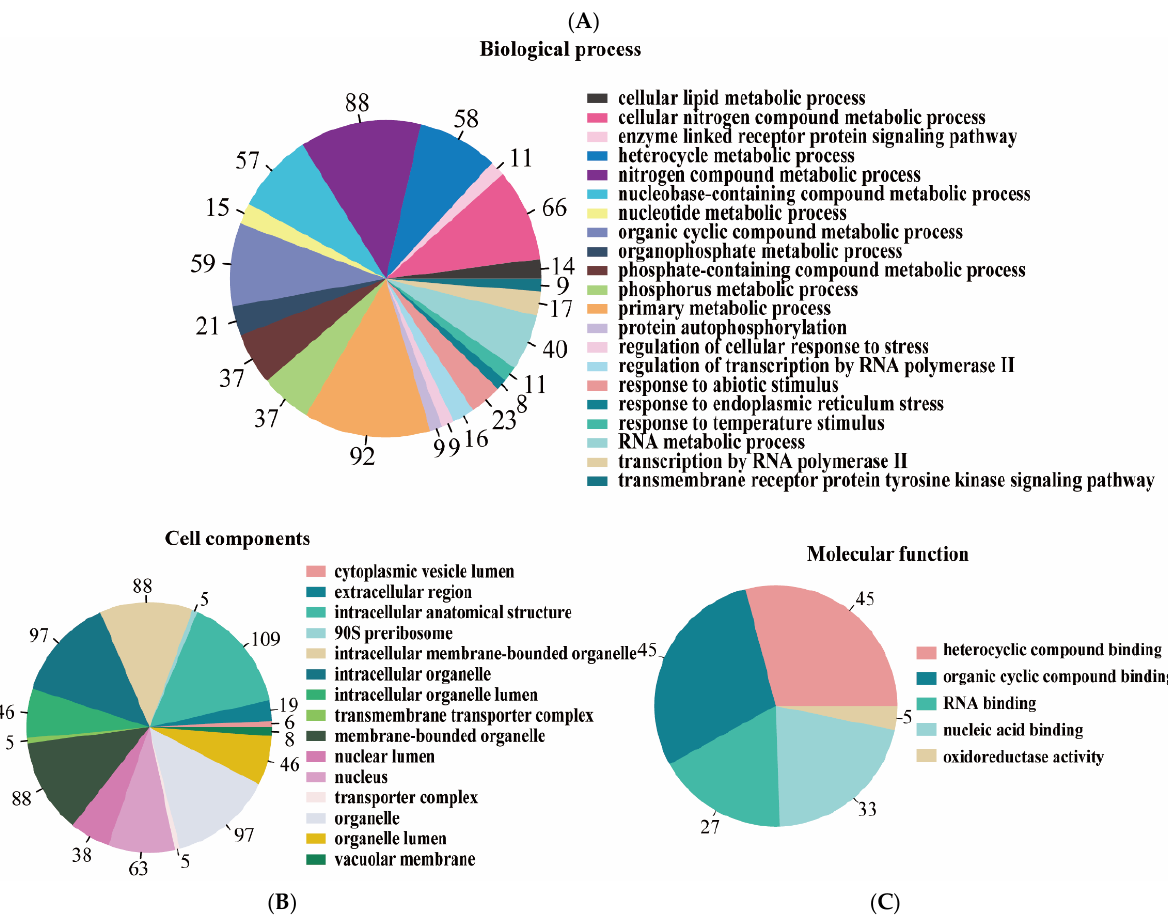
Figure 2. The GO enrichment of DEGs in the biological process category ( A ), cell components category ( B ), and molecular function category ( C ).